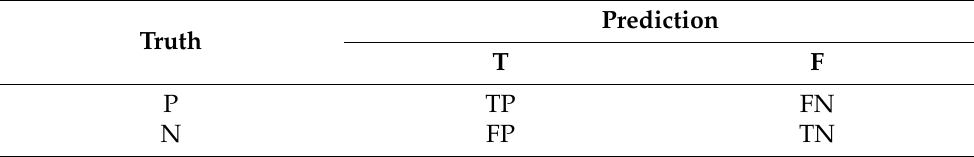
Table 1. Confusion